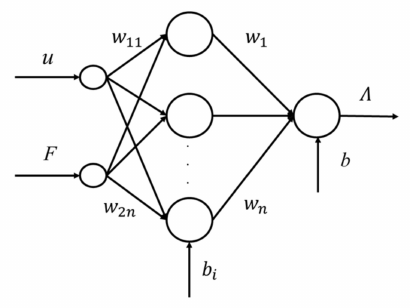
Figure 3. Neural Network diagram of u ( t ) coupling with F ( t